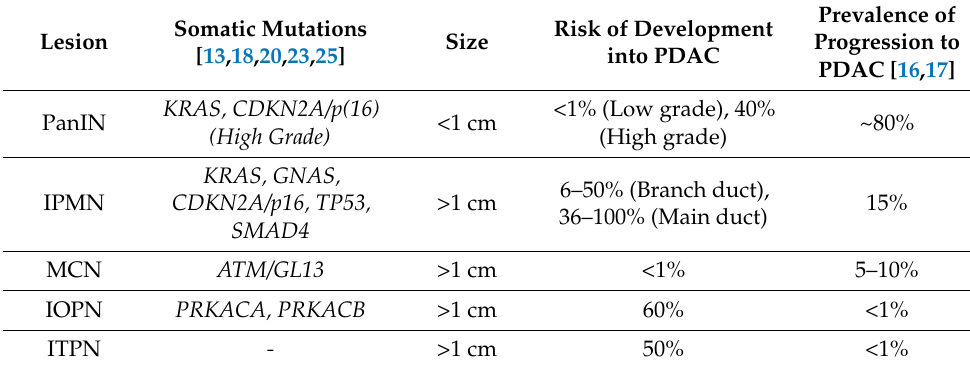
Table 1. Summary of pre-cursor